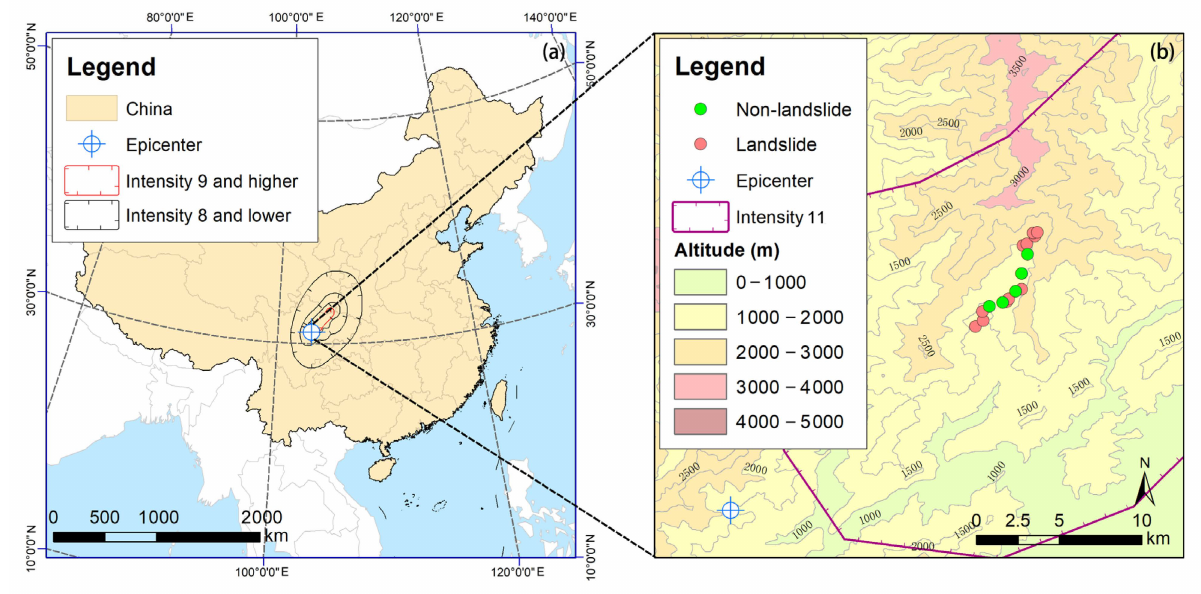
Figure 1. Study area. ( a ) Ranges of areas with different earthquake intensities; ( b ) locations of sample sites. The dotted line shows the location of the sampling area in ( a